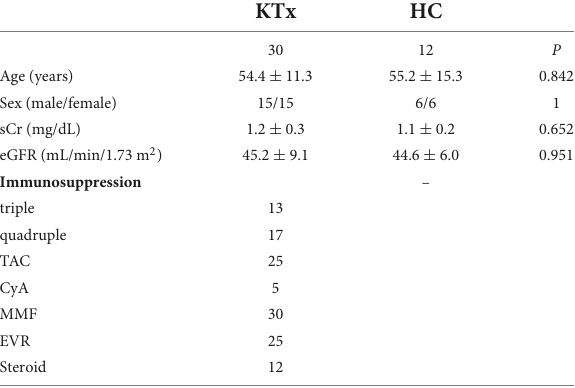
TABLE 2 Characteristics of KTx recipients and HCs for which PBMCs were analyzed by flow cytometric